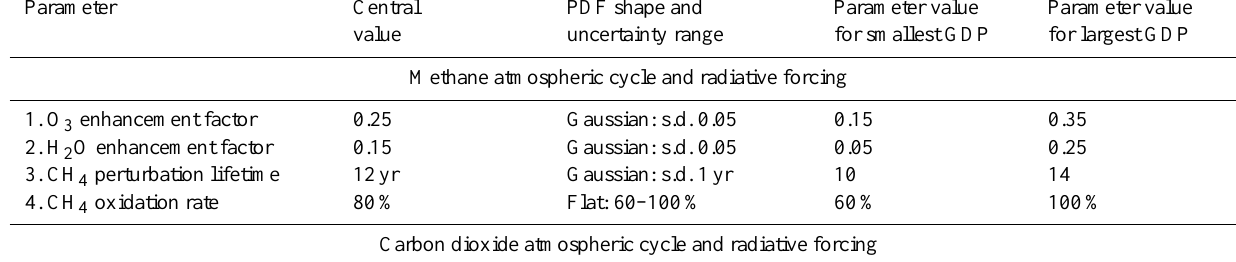
Table 1. List of parameters going into the calculations of the methane GWP, GTP and GDP. For each parameter the table provides the central value, the uncertainty range, and the values chosen to estimate the smallest and the largest possible methane CO 2 -equivalence.